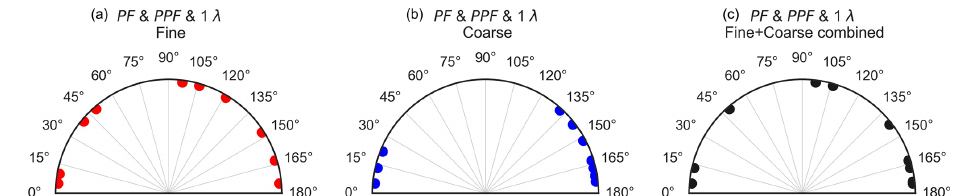
Figure 11. Panels (a) and (b) are optimal detection angle locations for the fine- and coarse-aerosol test cases, respectively, with phase function only and phase function and polarized phase function measurement cases. Panel (c) is the angular configuration constructed by combing fine and coarse configurations with q = 6 configurations; due to a common angle point, the resulting configuration has N comb = 10.